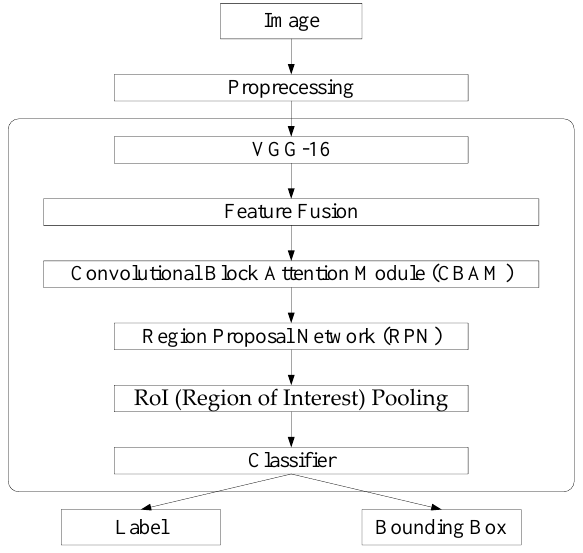
Figure 1. The proposed architecture.